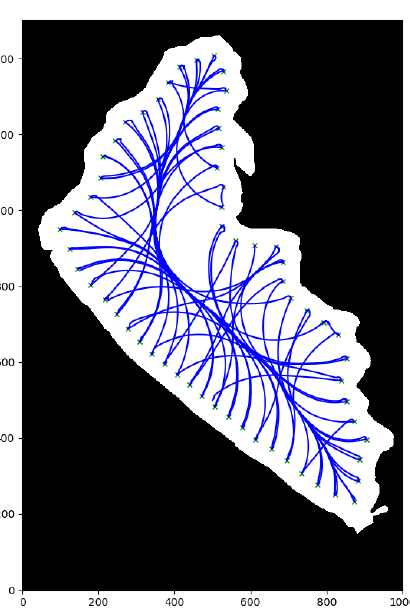
Figure 14. A* complete solution.